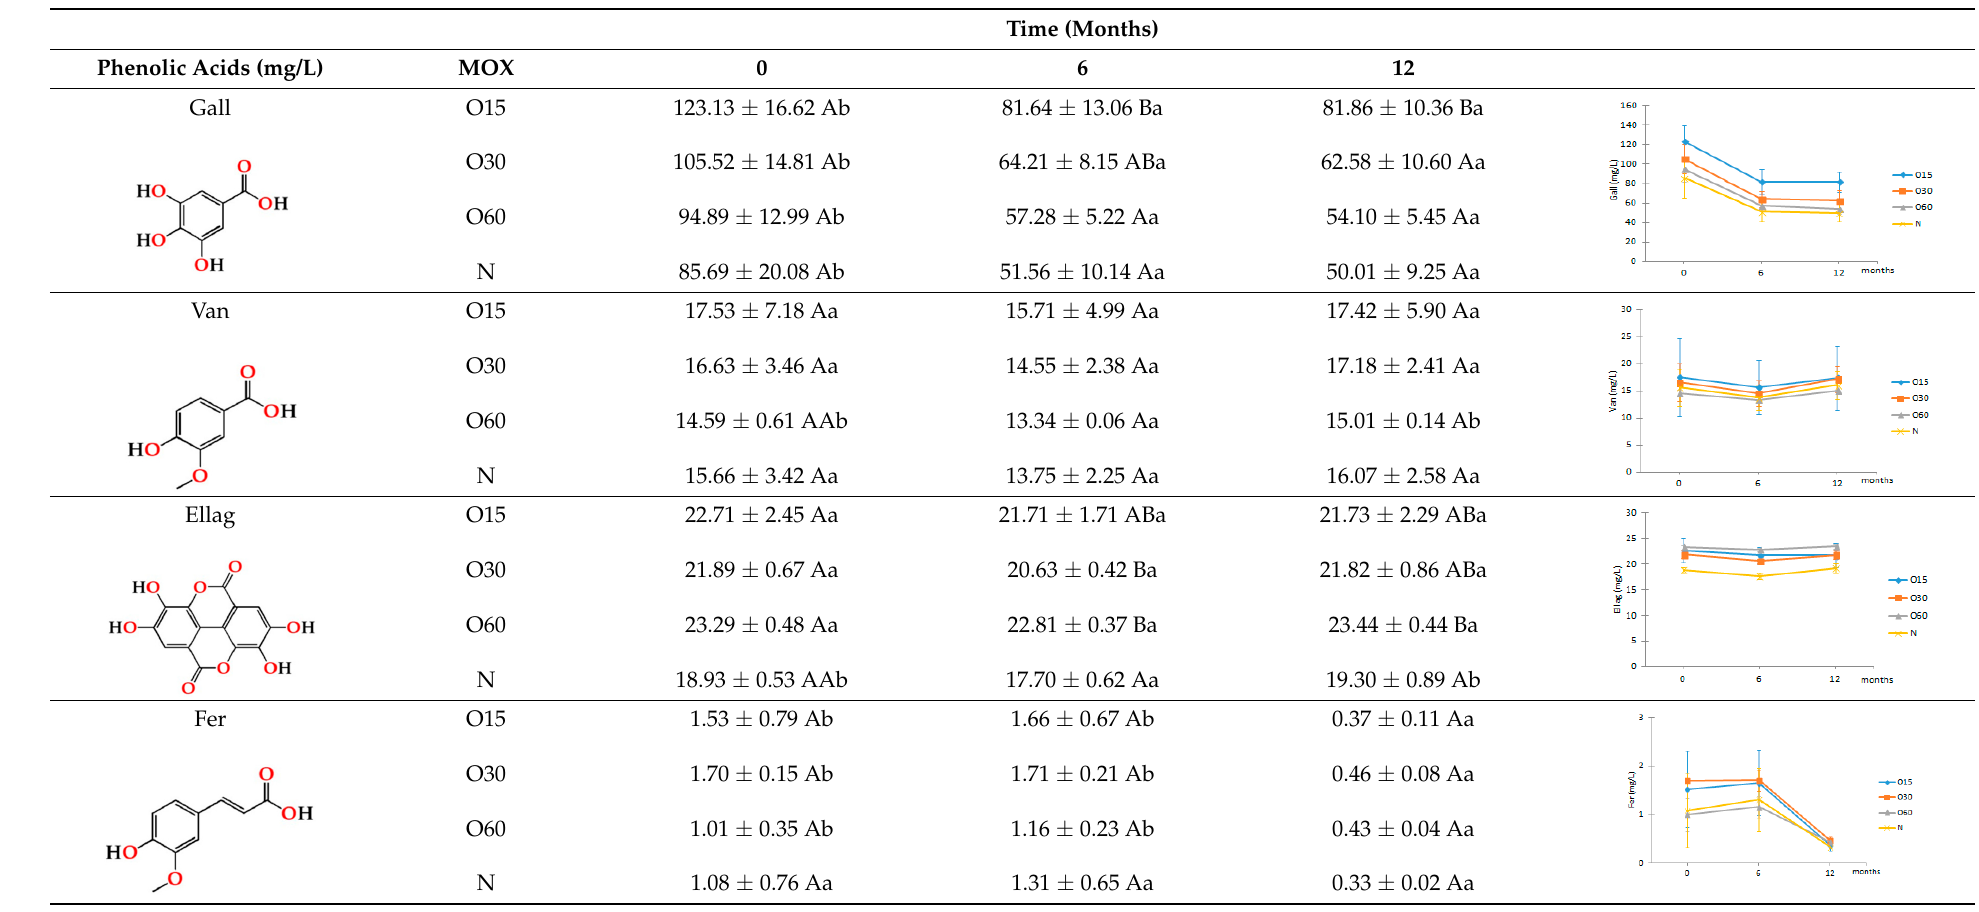
Table 1. Evolution of the phenolic acids from aged WS in each storage time (0, 6, 12 months) according to ageing modalities (O15, O30, O60 and N). Time (Months)